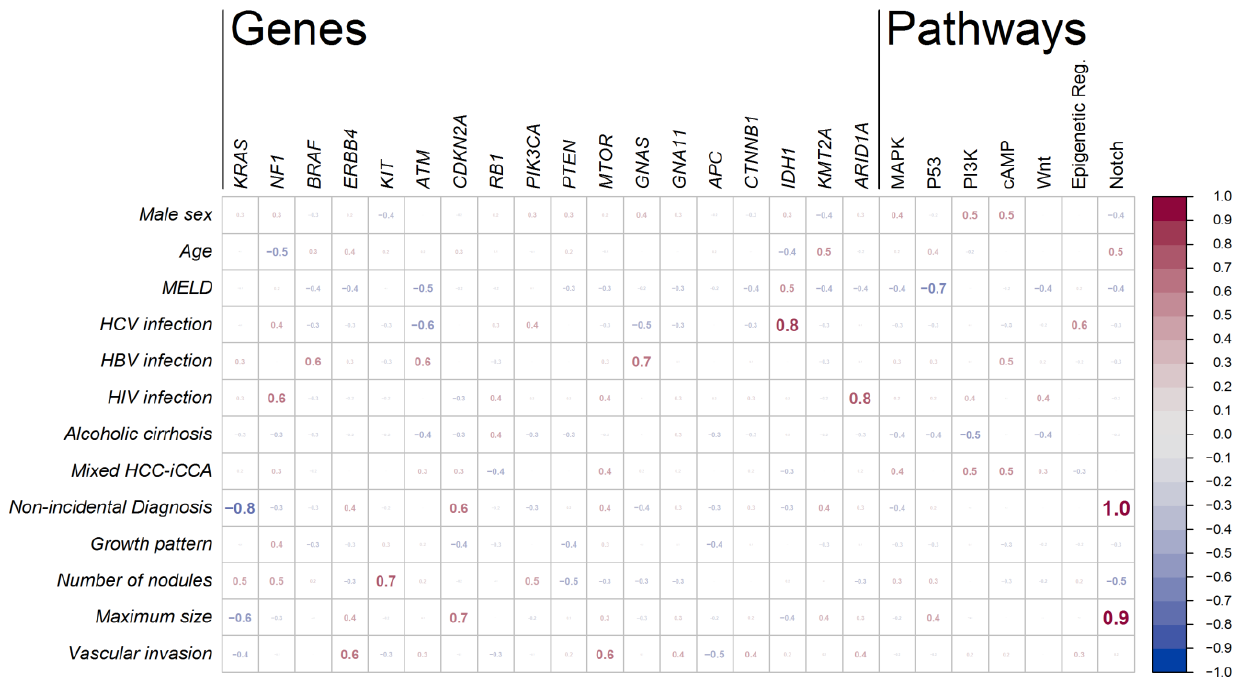
Figure 2. Association coefficients between mutations and clinical characteristics of the patients. Each cell represents the value (ranging from − 1 to +1) of an association index between a clinical characteristic of the patient (in row) and the presence of at least one mutation observed in the gene (in column). The last seven columns refer to the presence of at least one mutation observed in the group of genes involved in a biochemical pathway. Font size is proportional to the absolute value of the coefficient. Genes and pathways with mutations observed in one patient only were excluded. Reported association indexes are phi mean square contingency coefficient or the rho pb point-biserial correlation coefficient, as appropriate.